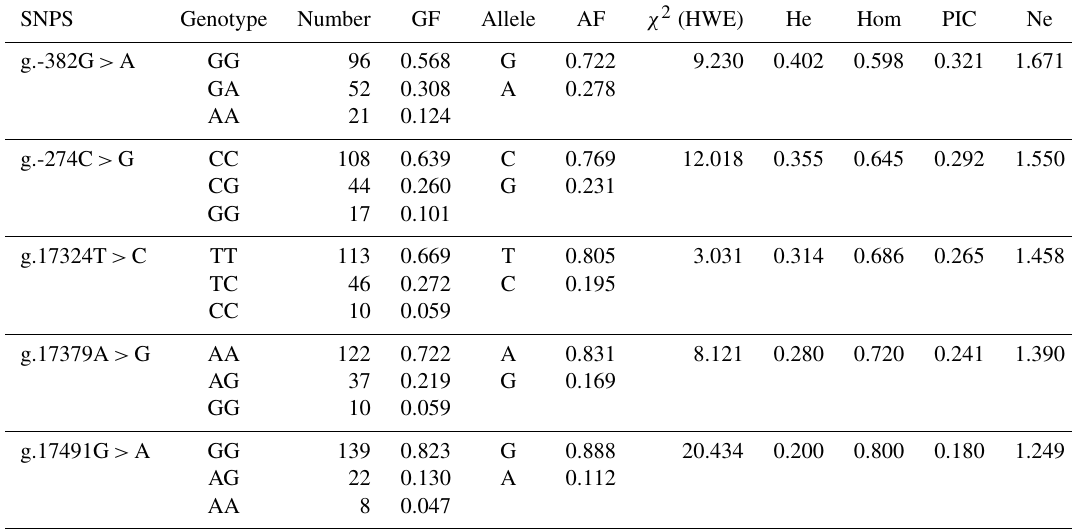
Table 2. Genotypic and allelic frequencies (%), value of χ 2 test, and diversity parameters of the bovine SIRT1 gene.